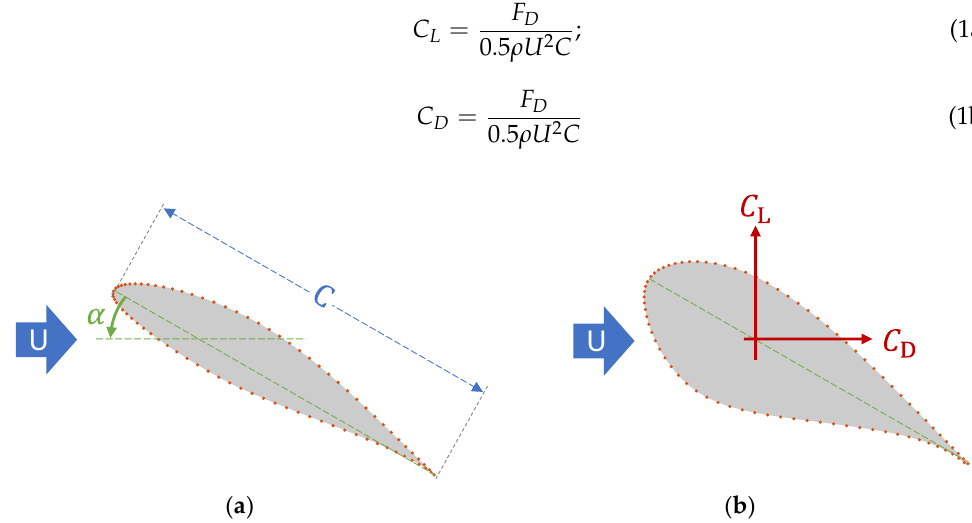
Figure 1. Airfoils studied in this work: ( a ) NACA64 and ( b ) DU40. The dots on the airfoil surface represent the edges of the surface panels.